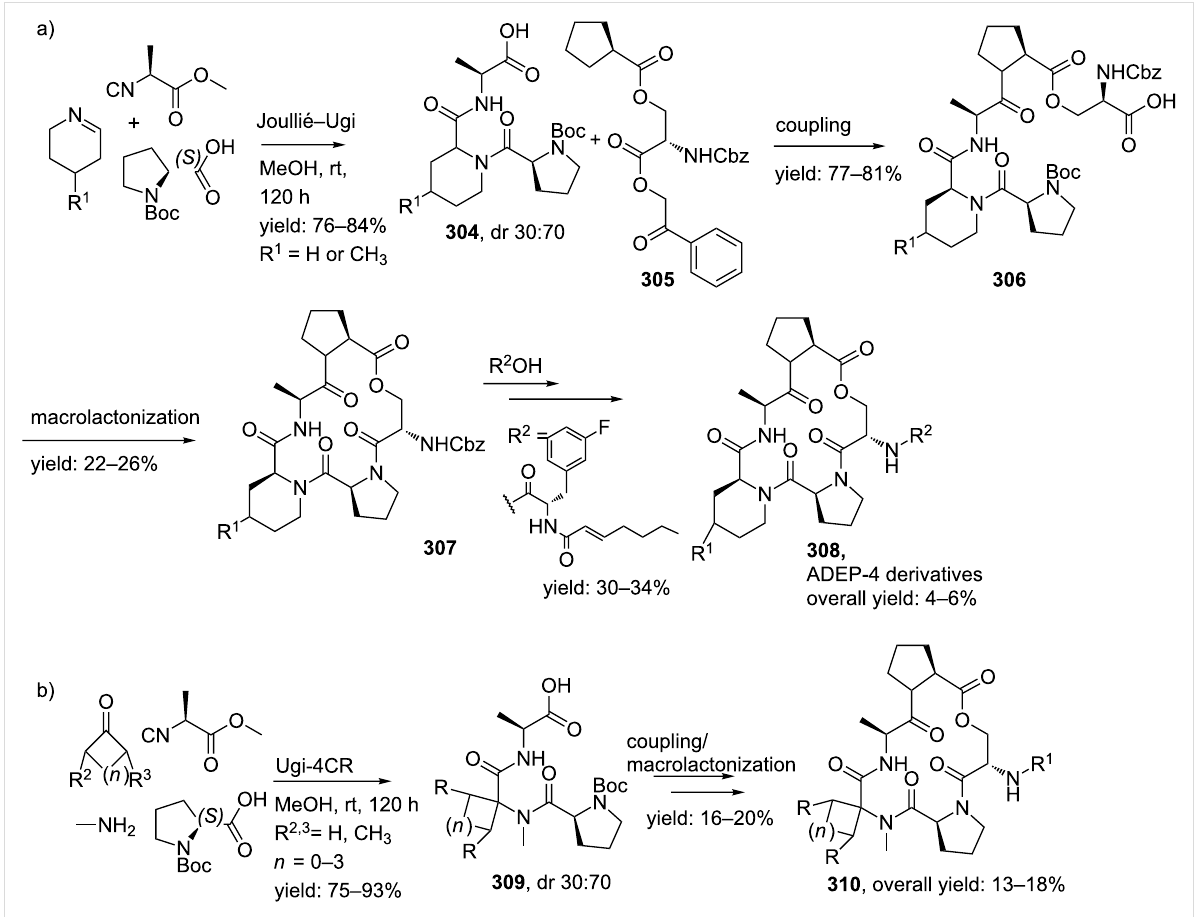
Scheme 89: a) The Joullié–Ugi-approach towards ADEP-4 derivatives b) Ugi-approach for the α , α -dimethylated